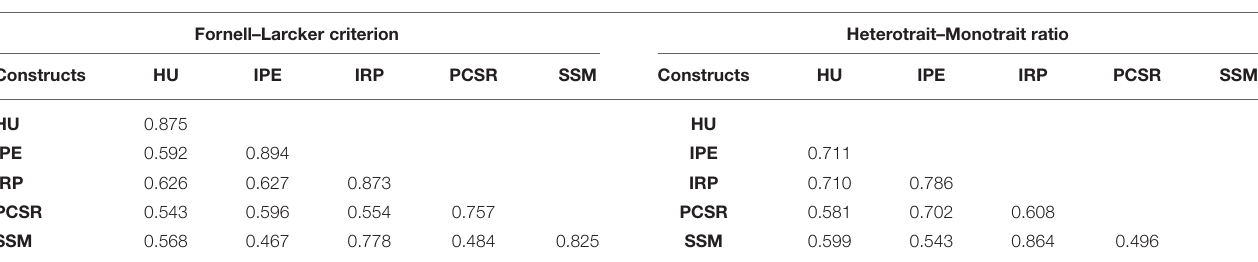
TABLE 3 | Discriminant validity.